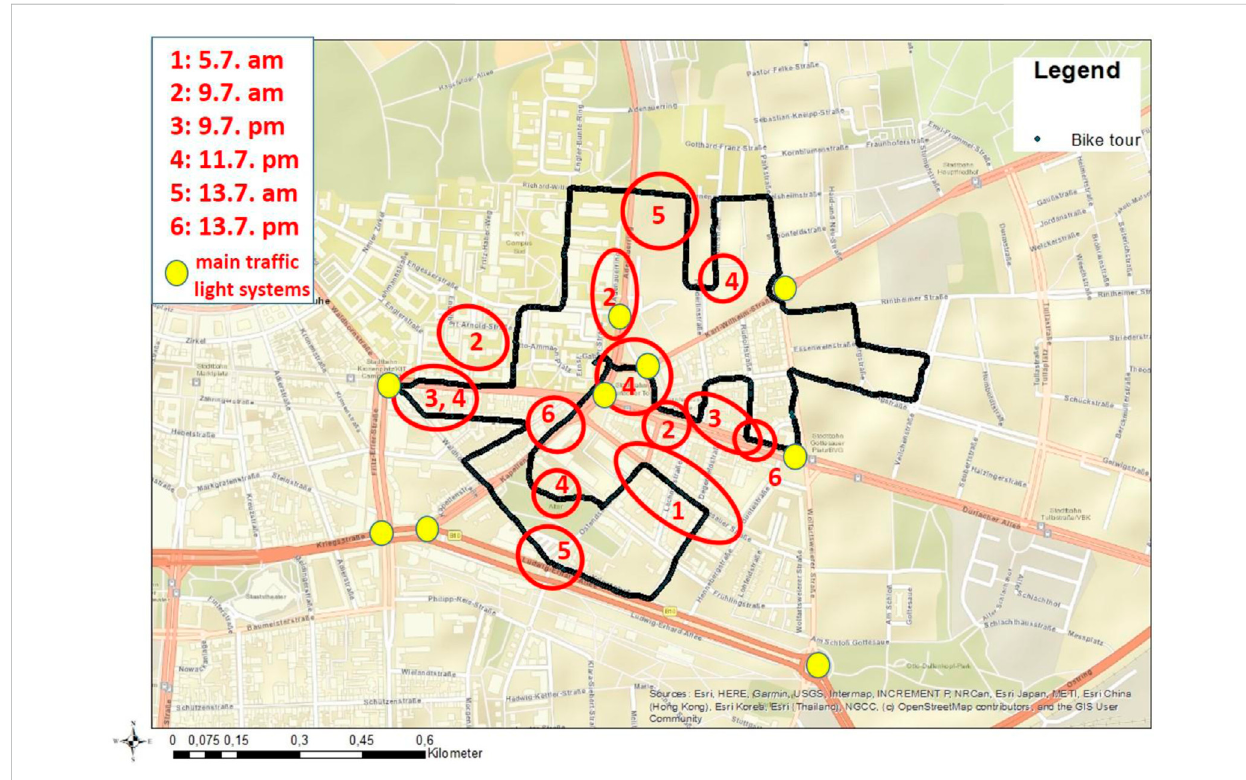
Hot spots of aerosol pollution (red circles) during the different recording